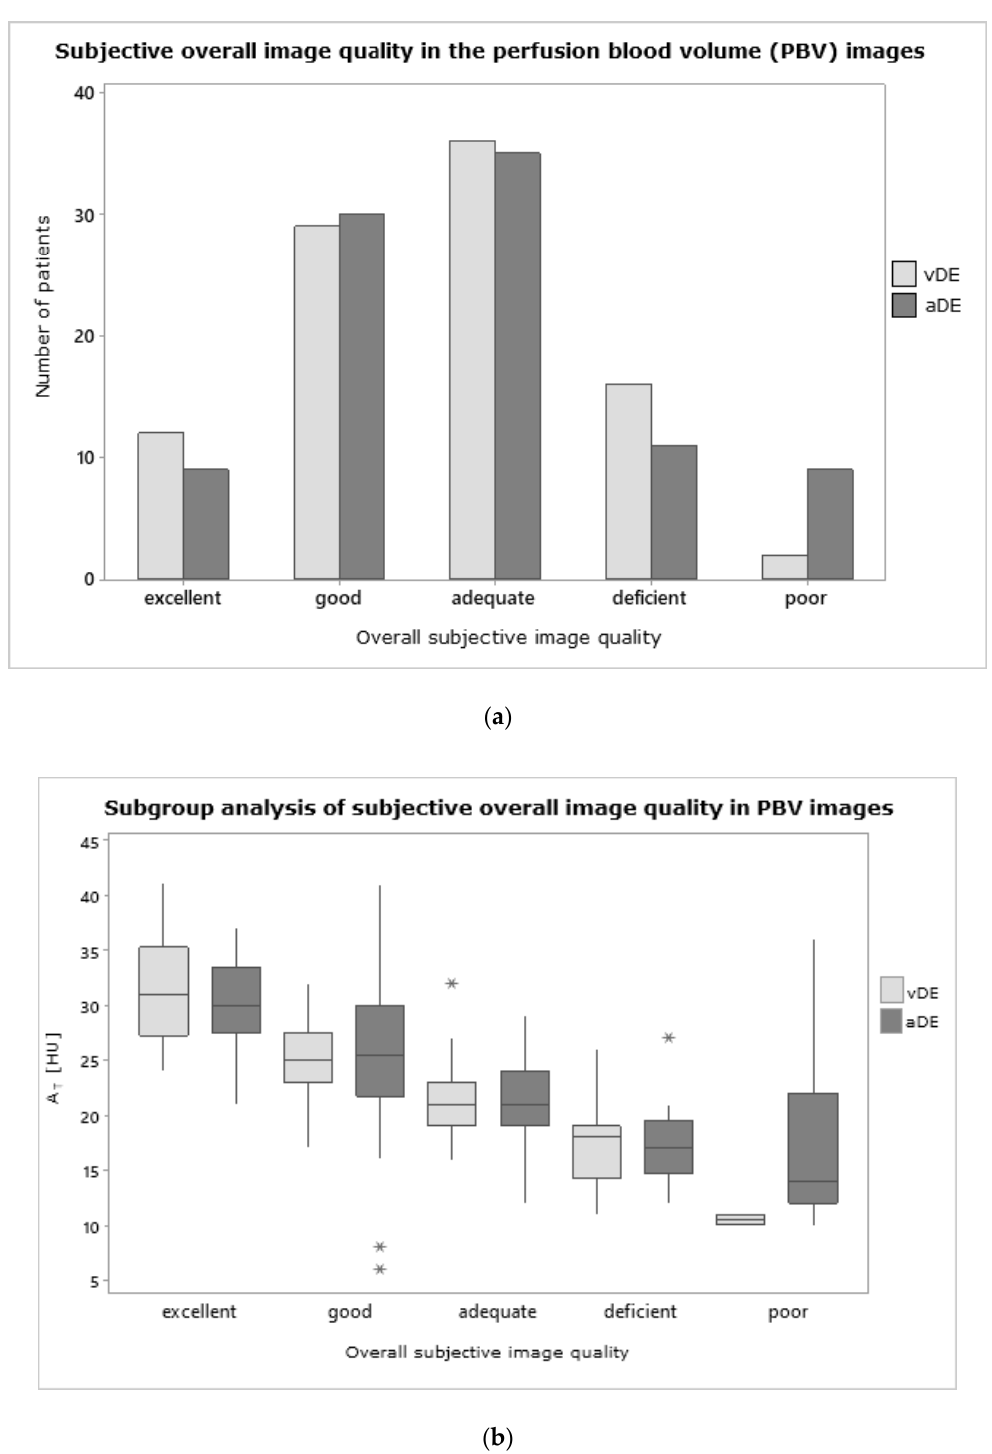
Figure 5. ( a ) Prevalence of subjective overall image quality in the perfusion blood volume (PBV) images compared between the study (vDE—portal-venous thoraco-abdominal Dual Energy CT) and the reference group (aDE—pulmonary arterial Dual Energy CT). ( b ) Subgroup analysis of the mean relative attenuation of the lung parenchyma (AT) in dependence of the subjective overall image quality in the PBV images. * p = 0.10.